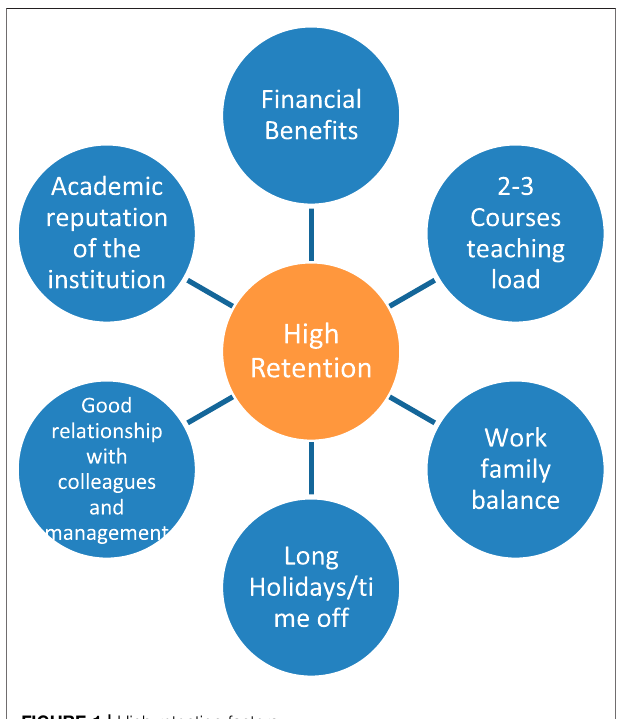
FIGURE 1 | High retention